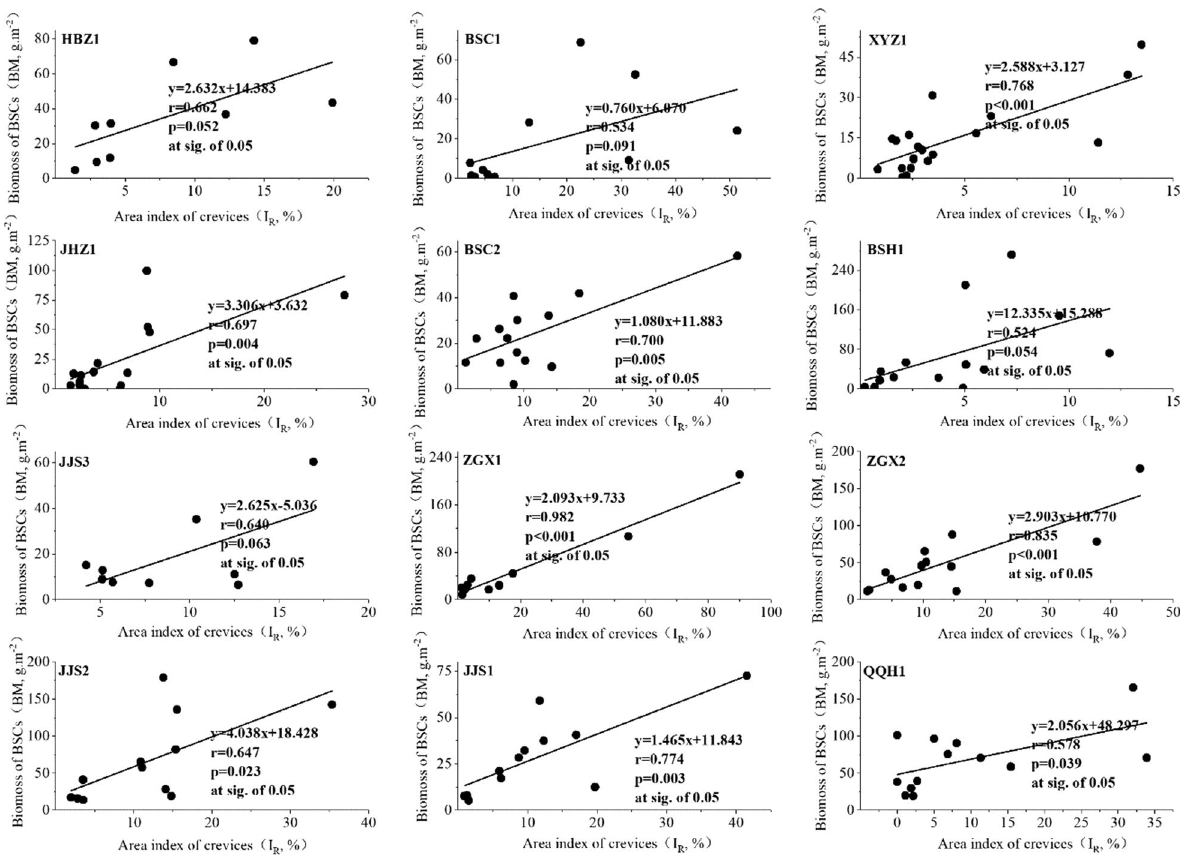
Fig. 5 Plots of BSC biomass and area index of crevices at 13 sampling sites